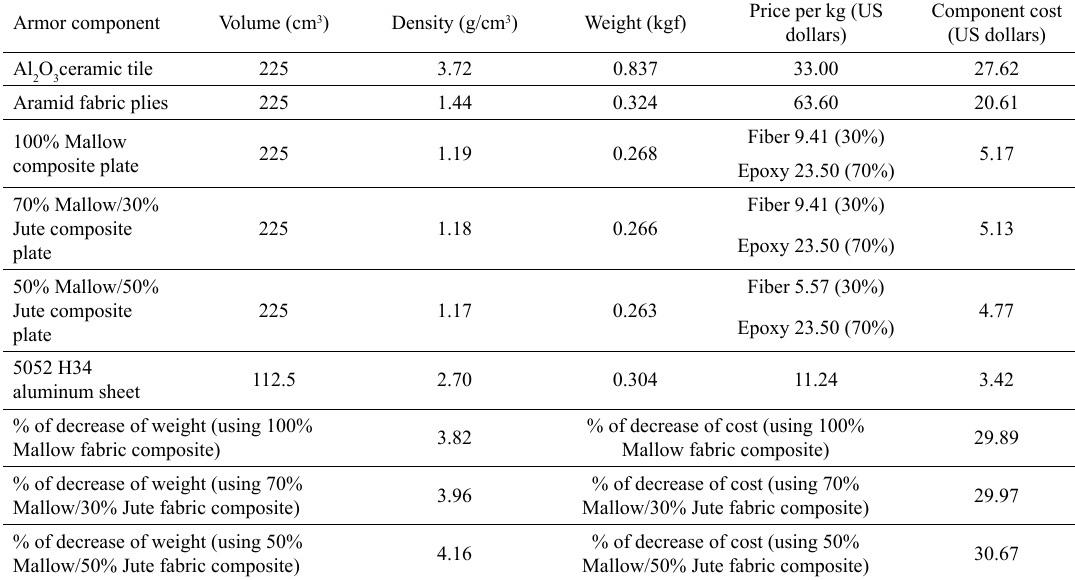
Table 3. Evaluation of weight and cost of the different multilayered